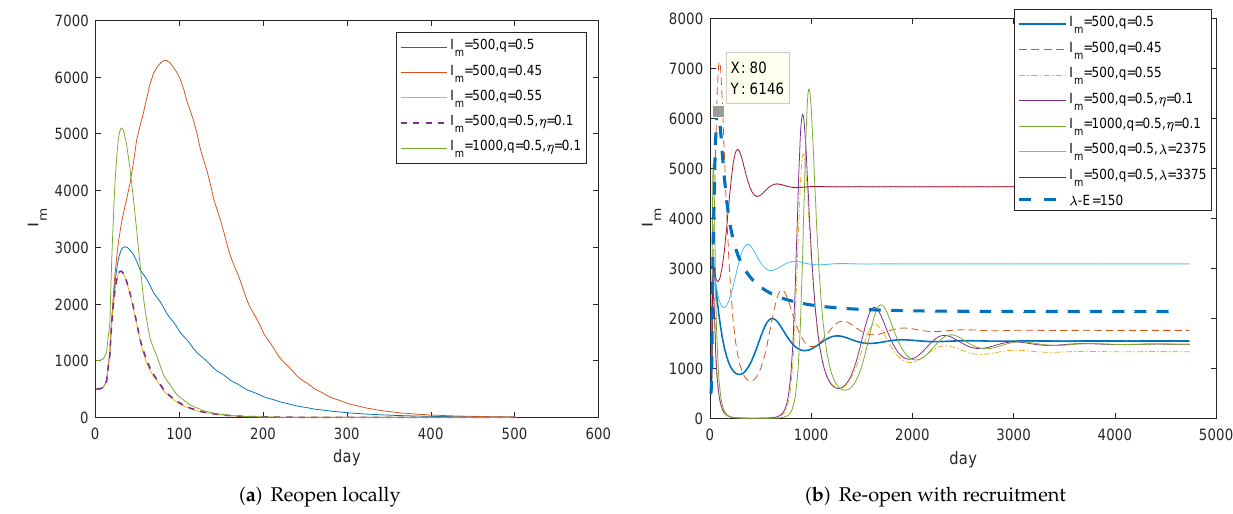
Figure 10. Investigations for re-open. ( a ) With at least 50 percent contact tracking rate, it is the time to reopen if the daily visiting patients are around 500 continuously. ( b ) Compared with (a), I m ( t ) ≤ 500 and q ≥ 0.5 are still the conditions for re-open. However, an endemic disease will form due to the recruitment. The first five curves correspond to λ =